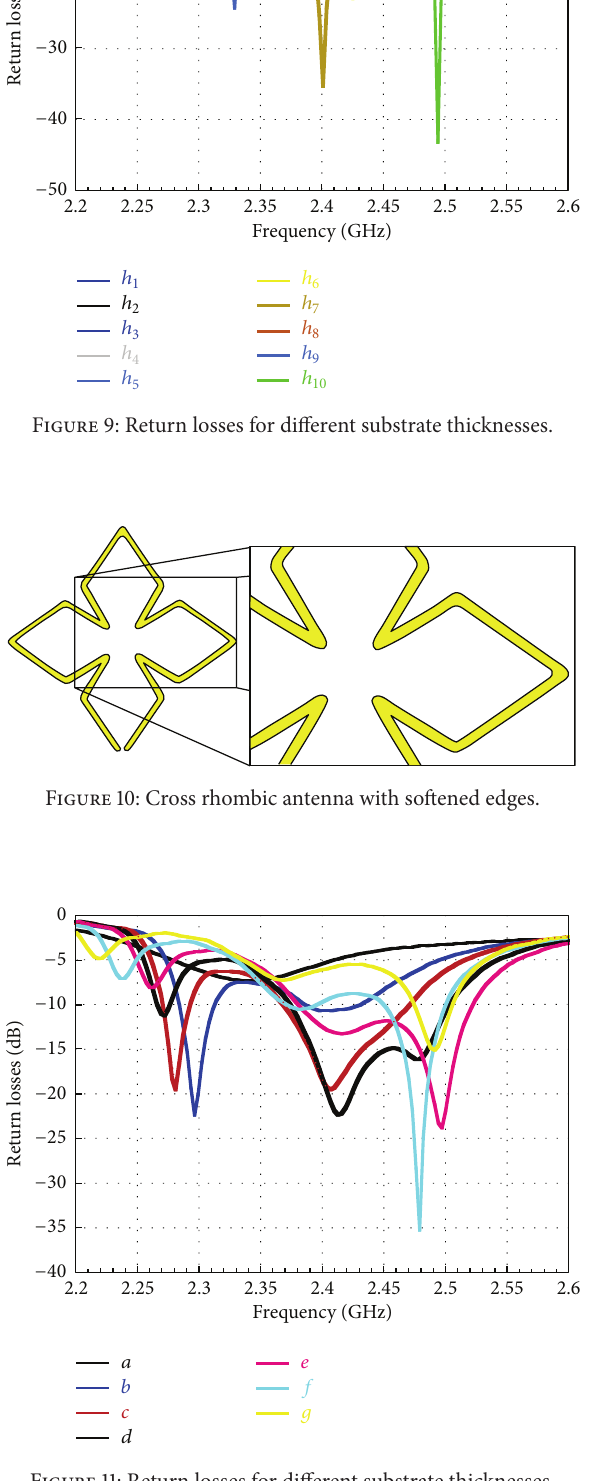
Figure 11: Return losses for different substrate thicknesses.